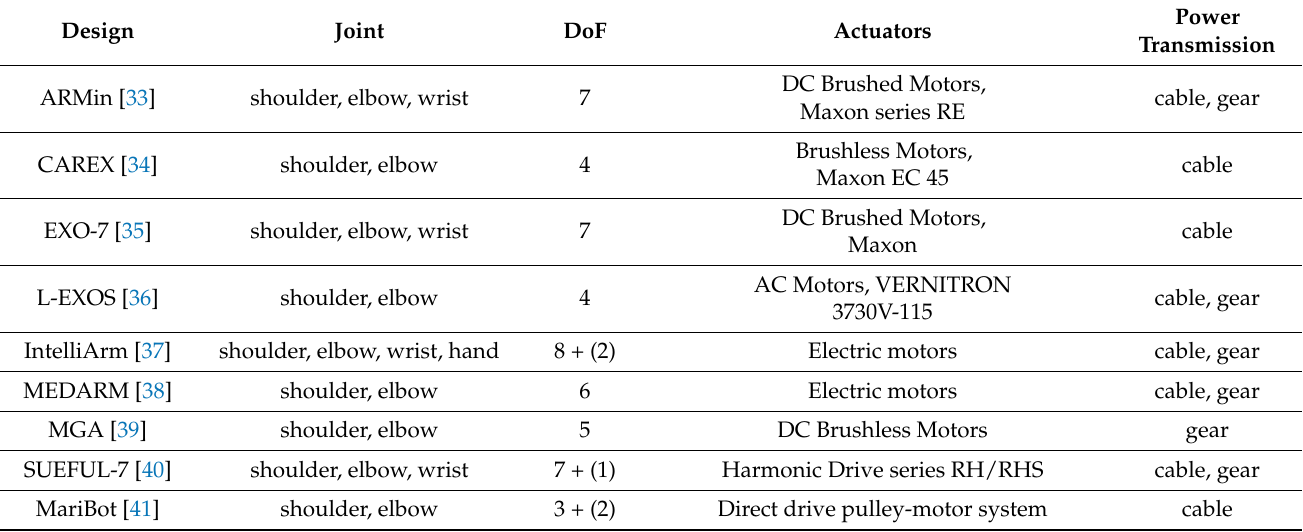
Table 1. Existing upper-limb rehabilitation/exercising exoskeleton robots.